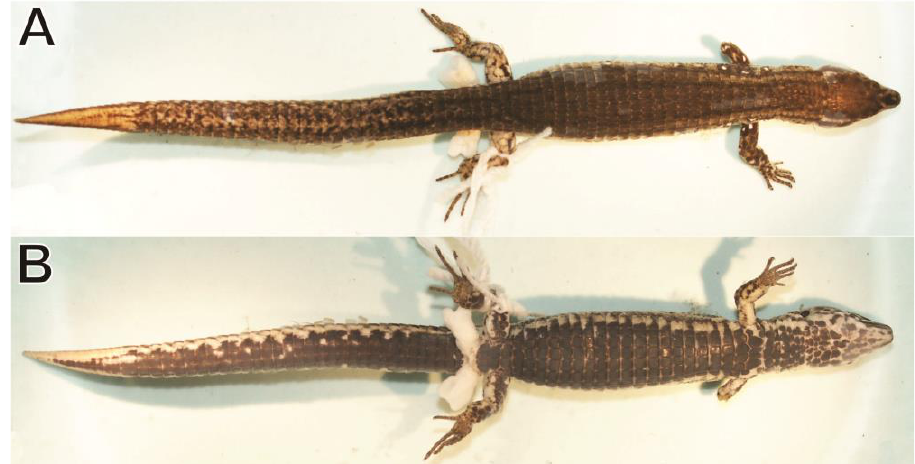
Figure 5. Preserved holotype of Proctoporus titans sp. nov. (MUSM 40916, male) in dorsal ( A ) and ventral ( B ) views. SVL 53.9 mm.